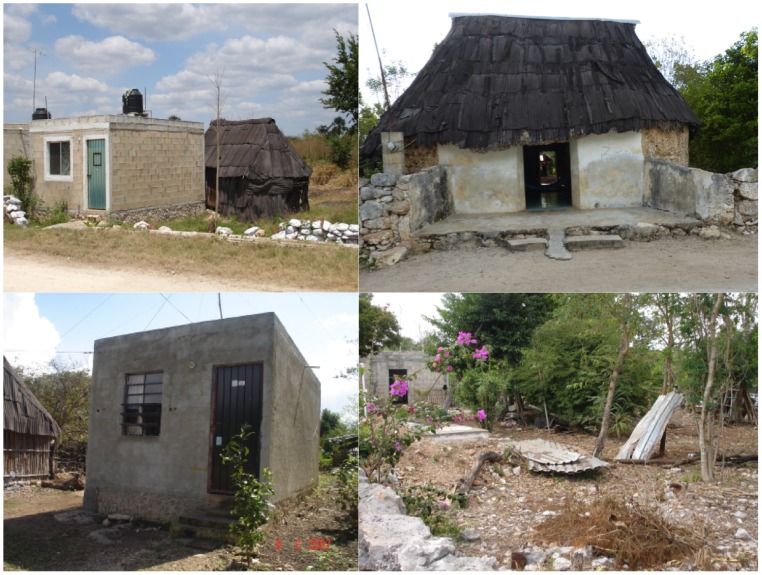
Typical housing and peridomestic structures in rural Yucatan, Mexico.